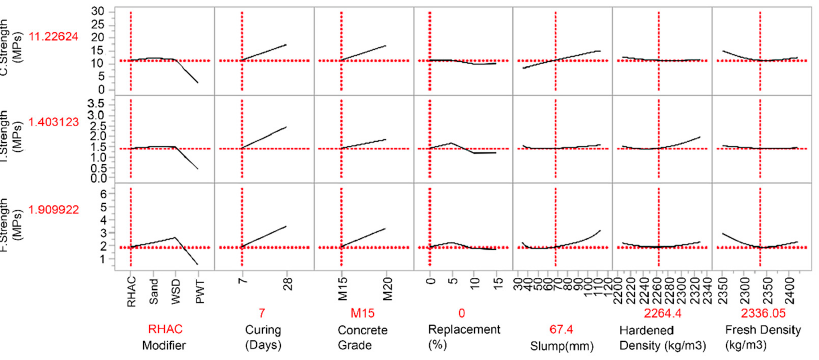
Figure 5. Contour plot of compressive/tensile strength (MPa) vs. mod, replacement (%). Above the contour plot shows that the most balanced modifier as filler materials is sand, but only RHAC (rice husk ash concrete) is almost performing as that material as rice husk ash is performing as good filler. WT showed a poor balance ratio as compare to other modifiers. Even so, no modifier crosses the ratio of 12.5, which proves the imbalance fluc- tuations of these mechanical (compressive/tensile) properties. Similarly, another balance in strength is required between compressive strength to flexural strength ratio. The con- tour plot shows that the most balanced modifier as filler materials is sand, but only RHAC is almost performing like that material as filler, as shown in Figure 6. In this case, WSD exhibits good balance characteristics that balance ratio values range from 4–4.5. As com- pared to the above figure, a very fine balance situation can be seen in Figure 7. This means all modifiers illustrate the same balance behavior up to 4% substitution except RHAC. The contour plot among the tensile/flexural strength ratio is shown in Figure 8 below.